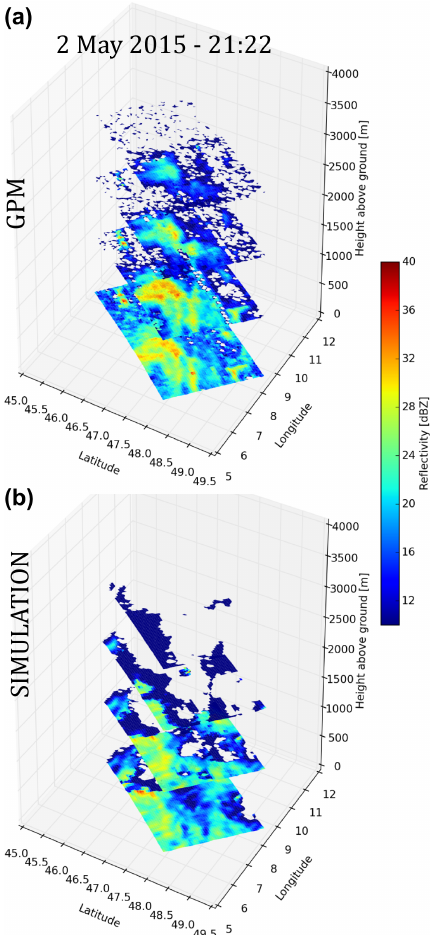
Figure 13. Example of comparisons at several altitude levels be- tween GPM radar observations at Ka band (a) and the correspond- ing radar operator simulation from the COSMO model (b) for one GPM